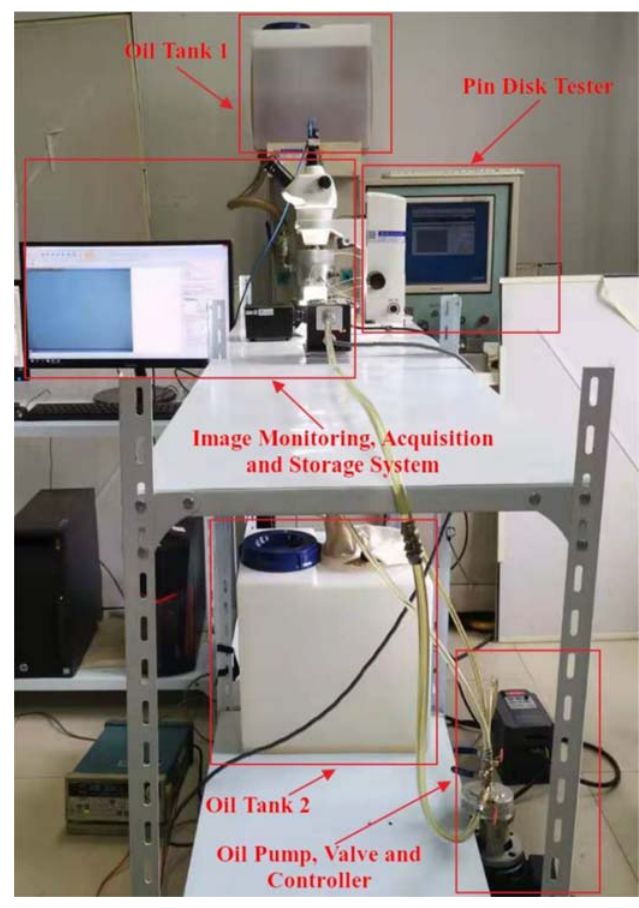
Fig. 3. Physical drawing of the experimental